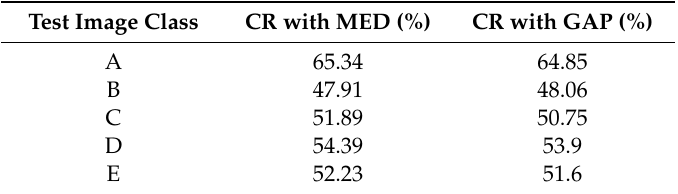
Table 3. CR comparison according to the prediction algorithm.